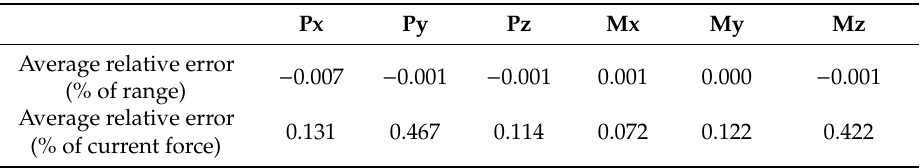
Table 1. Measurement error